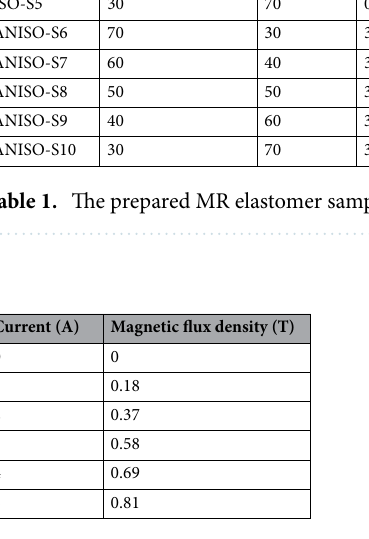
Table 2. The current applied equivalent to magnetic flux